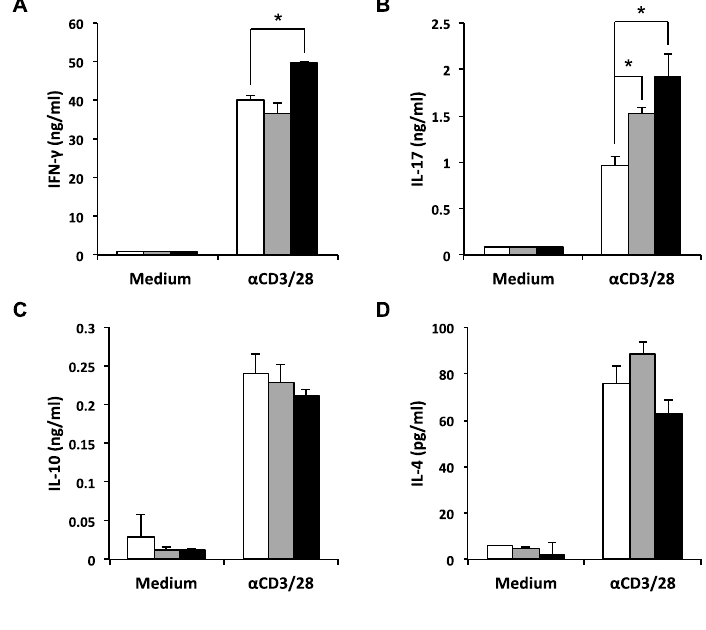
Figure 1. Cytokine production from the Peyer’s patch T cells derived from the mice orally administrated with lactic acid bacteria. Mice were orally administrated with 1 × 10 9 cfu heat-killed L. bulgaricus ME-552 or S. thermophilus ME-553 once daily. Lymphocytes from the Peyer’s patches were stimulated with anti-CD3 ε and anti-CD28 antibody for 48 h, and the levels of IFN- γ ( A ), IL-17 ( B ), IL-10 ( C ), and IL-4 ( D ) in the supernatant were determined by ELISA. Values are expressed as mean ± SD for three experiments. Different from the saline orally administrated, Student’s t -test was performed for p -values. * ; p < 0.05 vs control.